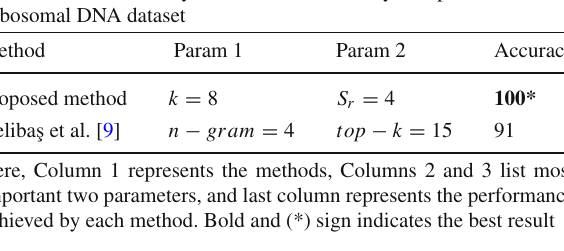
Table 9 DNA Similarity identification accuracy comparison for 18 Eutherian mammals mitochondrial DNA